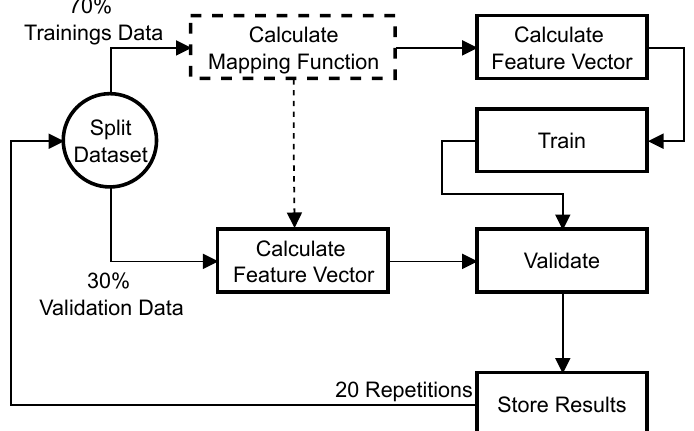
Figure 6. Steps performed for training and evaluation.